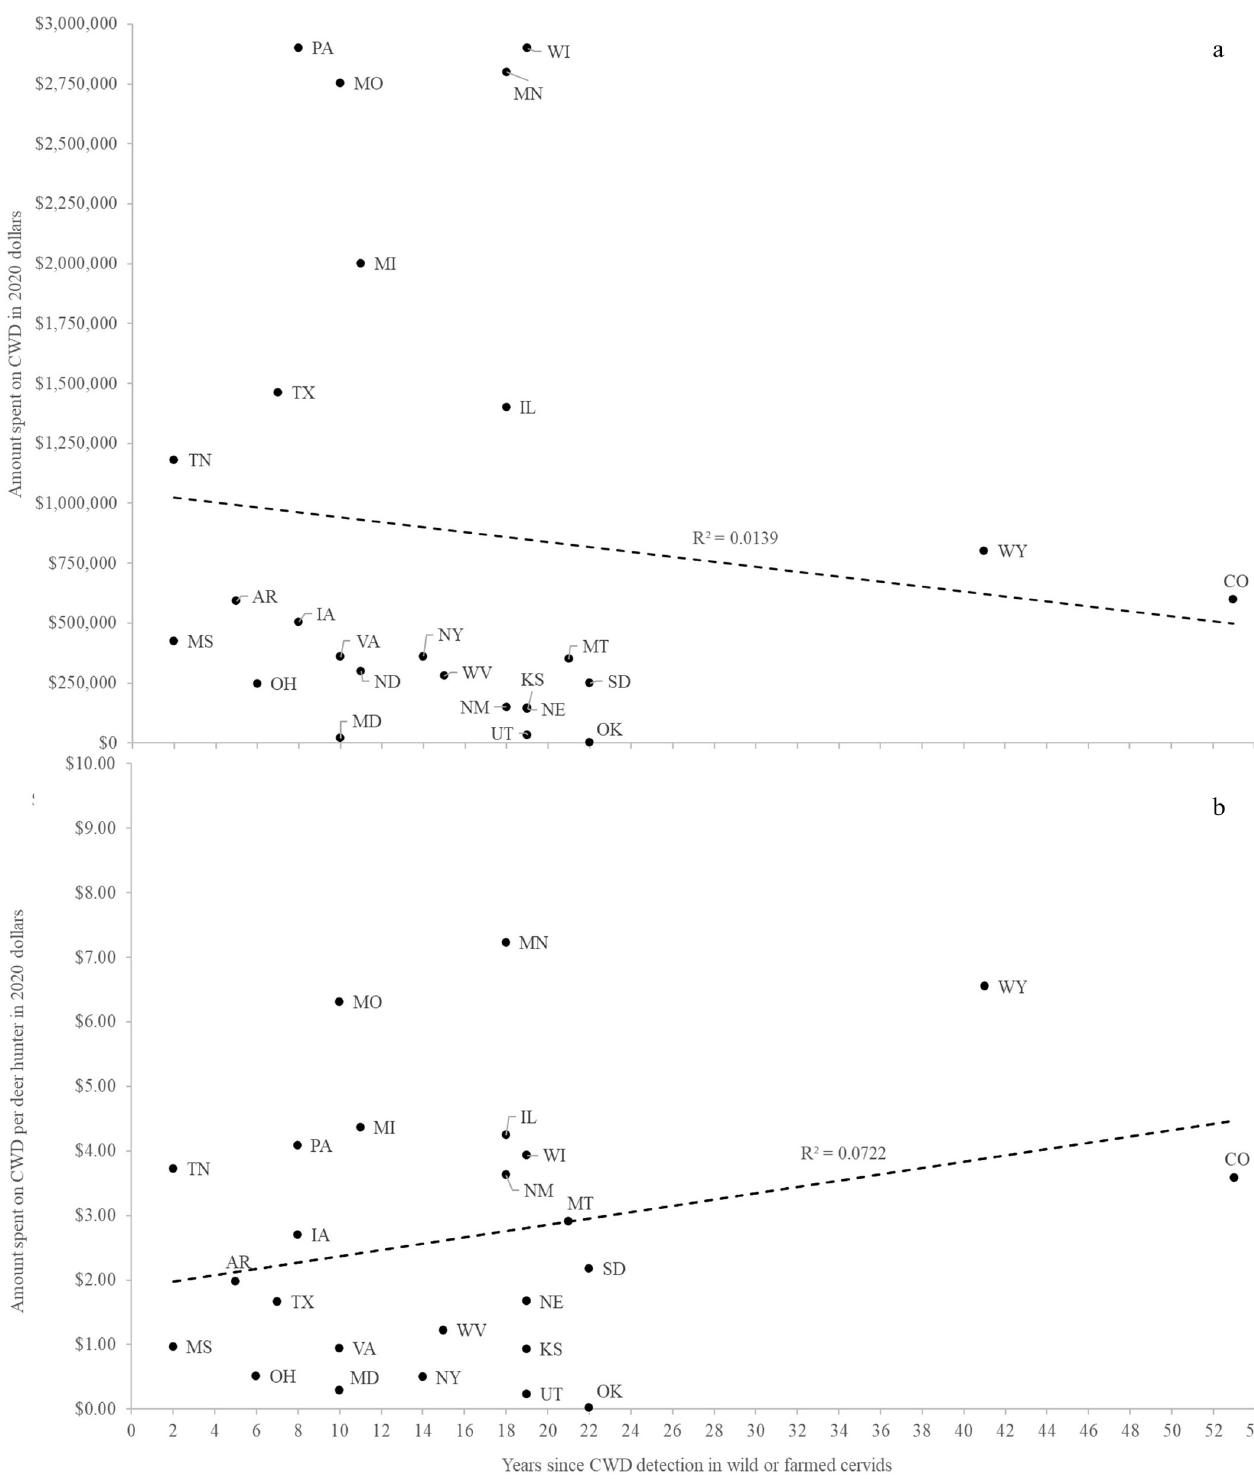
Fig 3. Relationship between time since chronic wasting disease (CWD) detection and money spent by state natural resources agencies on CWD-related work. Spending is displayed as (a) the relationship between time since CWD detection and spending and (b) the relationship between time since CWD detection and spending weighted by the number of deer hunters in each state. Deer hunter numbers were based on the 2011 National Survey of Fishing, Hunting, and Wildlife-Associated Recreation [35], the last year state-level data for deer hunter numbers were presented in the survey.